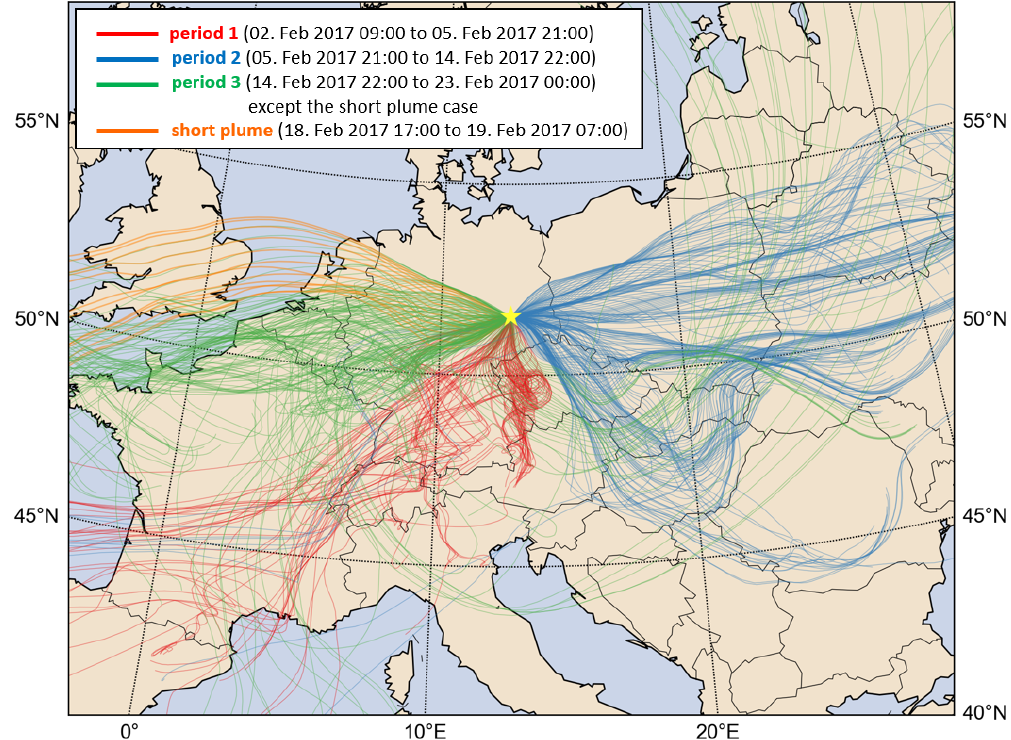
Figure 4. Map of air mass back trajectories: 96h air mass back trajectories terminating at Melpitz site (yellow star) at an altitude of 100m for every hour of the campaign. Trajectories terminating at altitudes of 10 and 500m were similar to those shown here. The map is based on the HYSPLIT atmospheric transport and dispersion modeling system provided by Air Resources Laboratory (ARL) (Stein et al.,